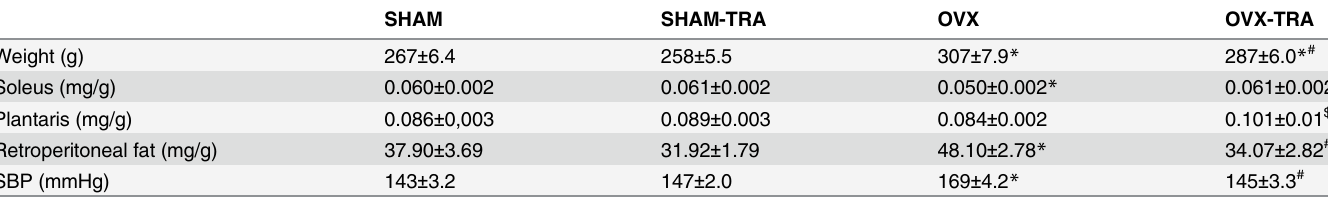
Table 1. Anthropometric and Hemodynamic data from SHAM, SHAM-TRA, OVX and OVX-TRA